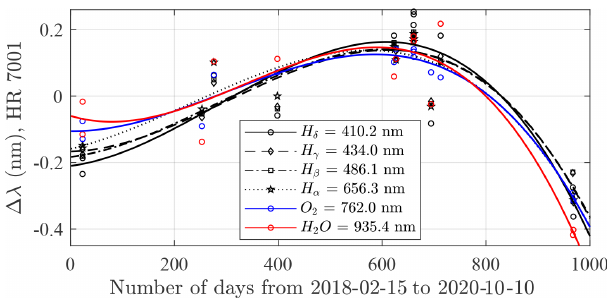
Figure 8. SPST09 spectral drift over several seasons for the stellar hydrogen absorption lines of the Balmer series and the atmospheric O 2 and H 2 O lines. The curves are third-order polynomial fits.